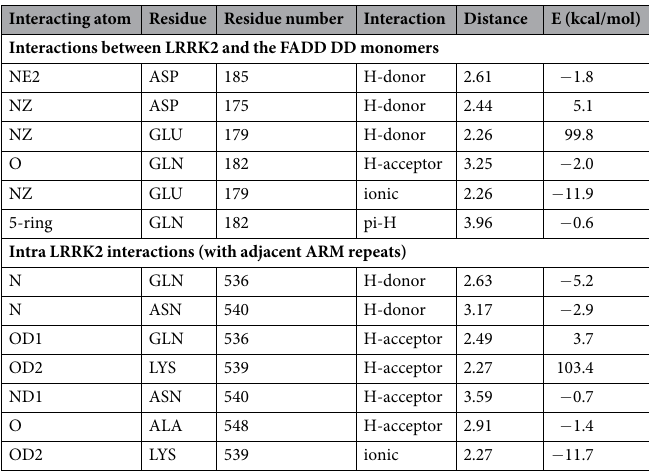
Table 1. Summary of molecular interactions between LRRK2 and FADD.